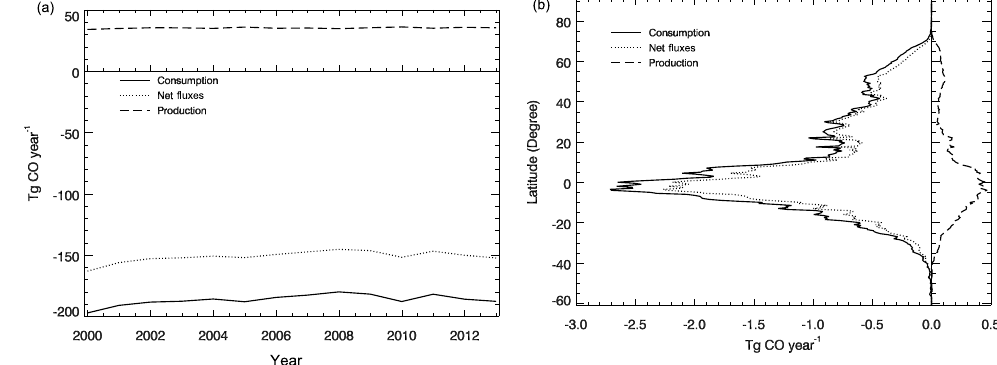
Figure 7. Global mean soil CO consumption, production and net flux: (a) the annual time series during 2000–2013 and (b) the latitudinal distribution during 2000–2013.